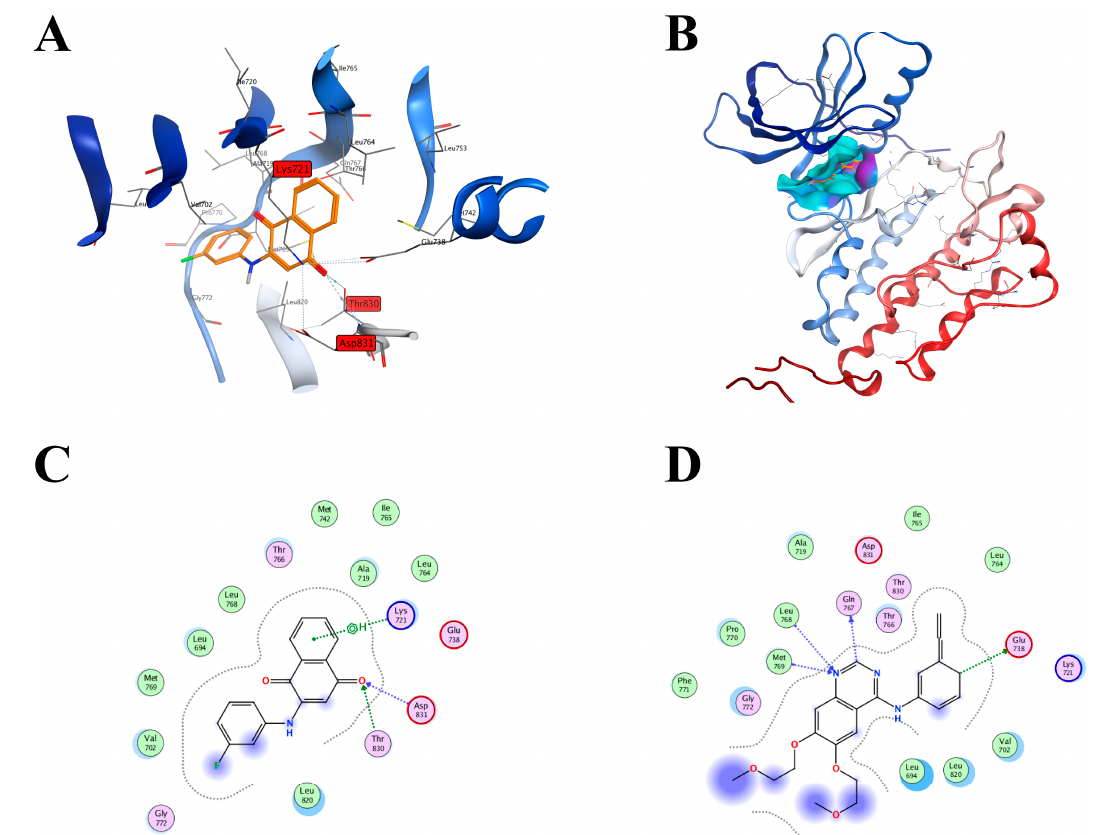
Figure 4. The binding mode of EGFR and compound 5i or Erlotinib. ( A ) The three-dimensional binding mode of EGFR and compound 5i : compound 5i is orange, residues around the binding bag are displayed in gray, and hydrogen bonds are indicated by dotted lines in light blue. ( B ) Surface binding mode of EGFR to compound 5i . ( C ) Two-dimensional binding mode of EGFR and compound 5i . ( D ) Two-dimensional binding mode of EGFR and Erlotinib.